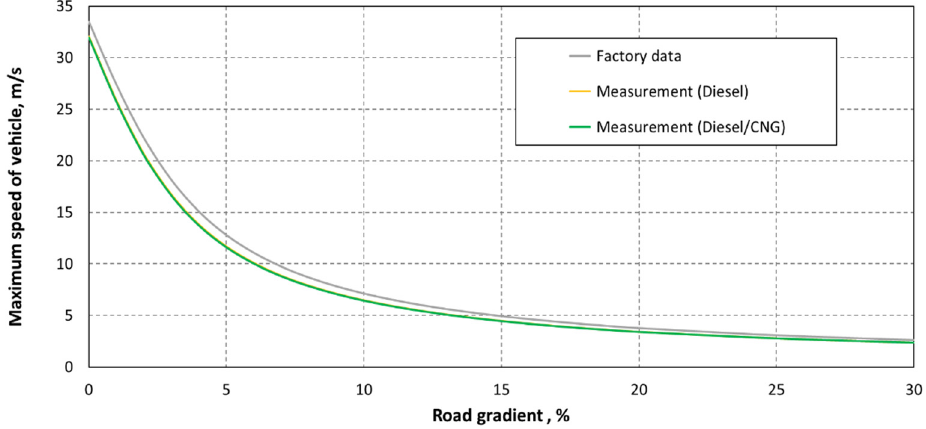
Figure 7. Change of the achieved maximum speed value depending on the road inclination angle.